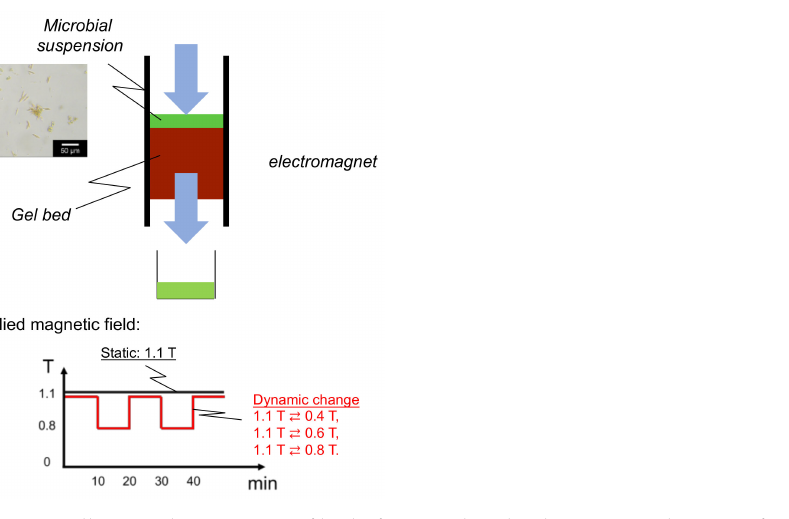
Figure A1. Illustrated equipment of bed of Mag gel in the dynamic application of a magnetic